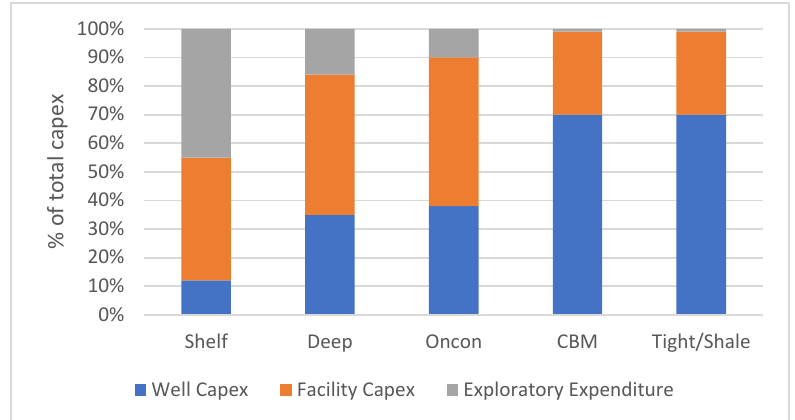
Figure 4. Breakdown of capital expenditure (capex) for individual field environments.